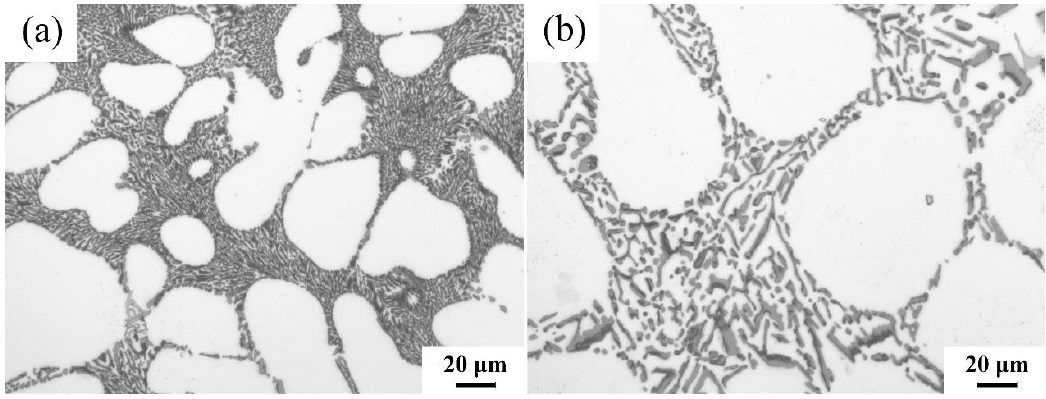
Figure 7. As cast microstructures of A356 alloys obtained by ( a ) metal and ( b ) sand molds.